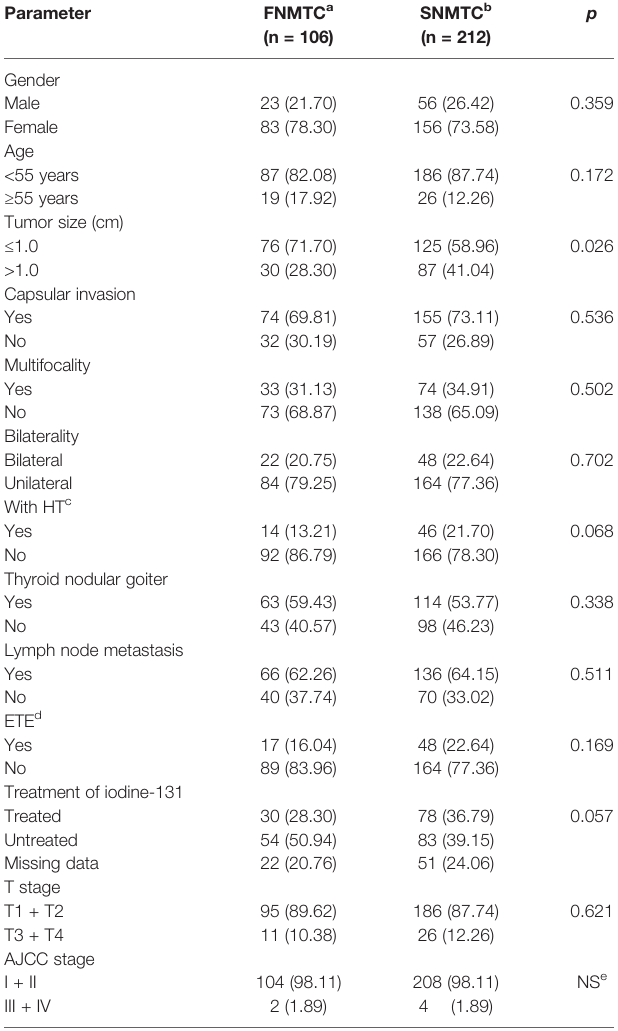
TABLE 1 | Clinicopathological characteristics and prognostic factors of FNMTC versus SNMTC, n (%).